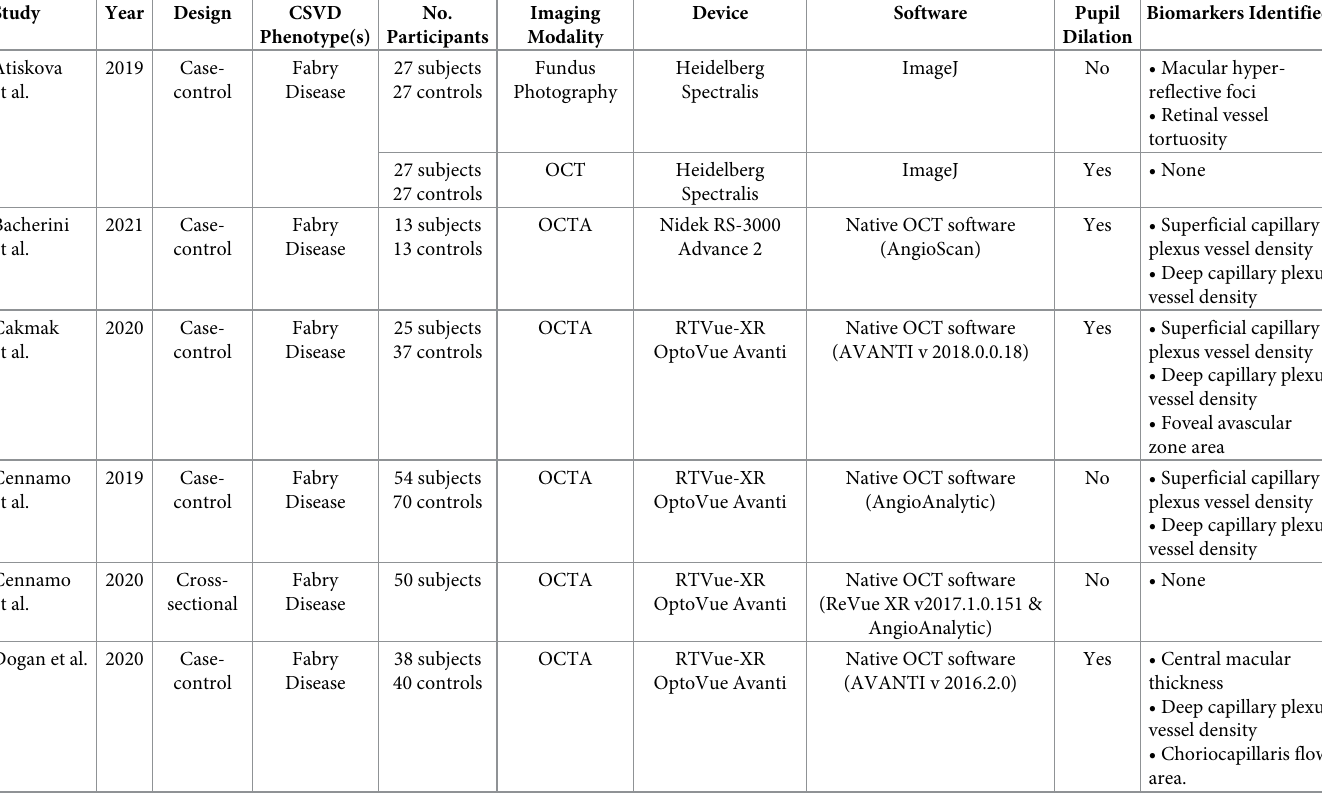
Table 5. Summary of design, patient characteristics, methodology and results for studies of Fabry